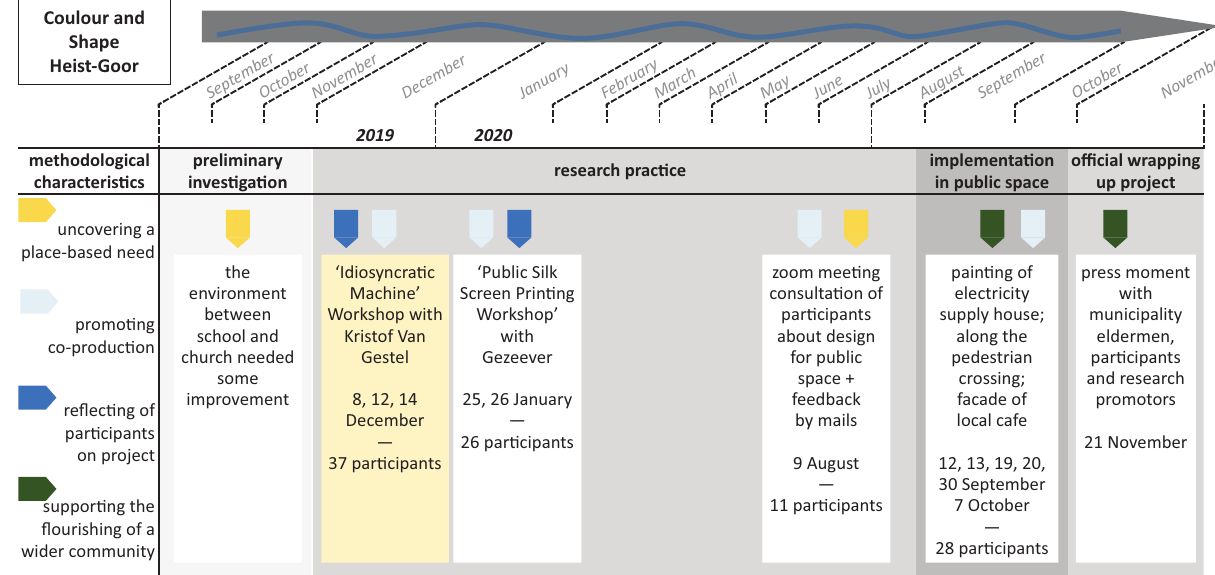
Figure 6. Artistic action research scheme for Colour and Shape Heist‐Goor . Source: Ruth